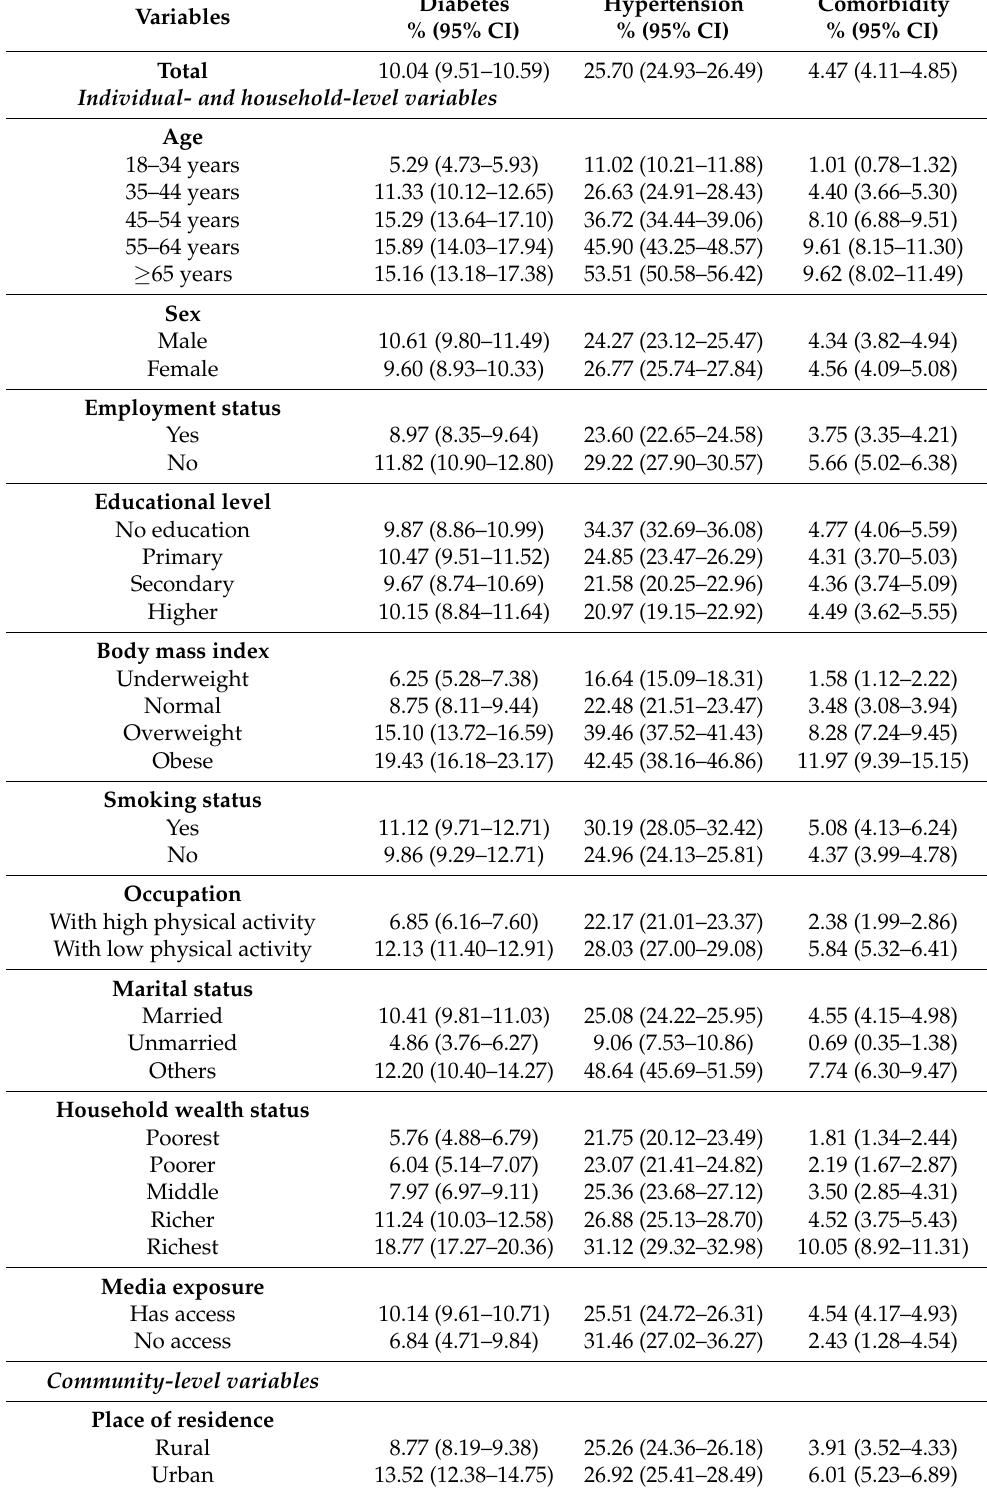
Table 2. Weighted prevalence of diabetes, hypertension, and comorbidity ( n =